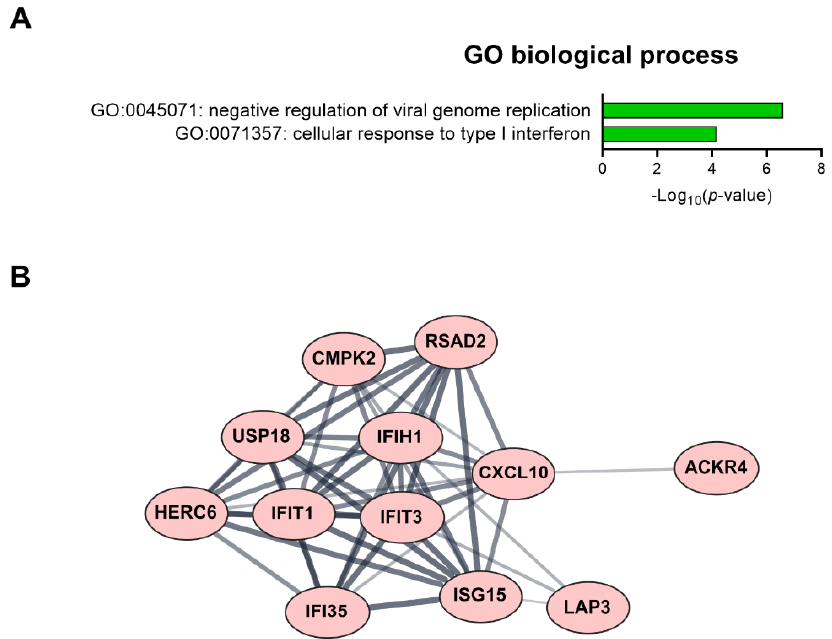
Figure 5. Fifteen candidate genes showing significantly modulated expression following low-dose radiation in both HAECs and T2D-HAECs. ( A ) Significant GO terms of biological process associated with the identified DEGs. ( B ) PPI network analysis identified the gene hub involved in the interferon signaling pathway.